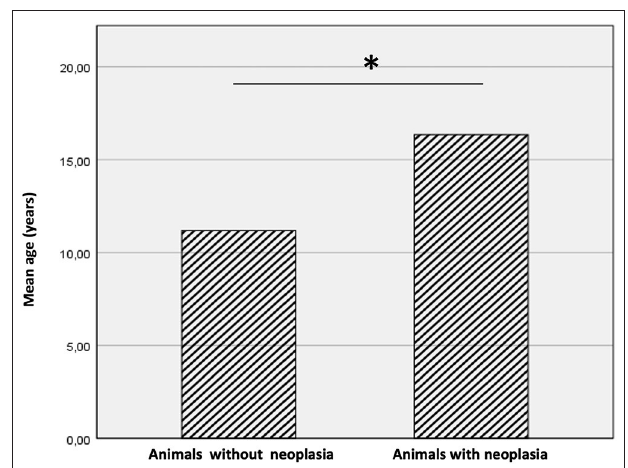
FIGURE 1 | Mean age of animals with and without neoplasia. The animals with cancer were significantly older than animals without neoplasms. The * symbol indicates the value of P <